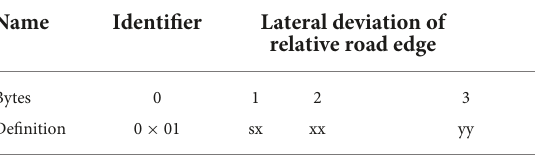
TABLE 3 A relative wayside pose information data